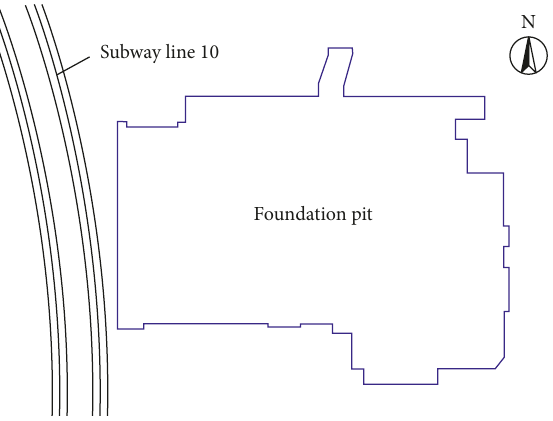
Figure 1: Plane position map of pit and